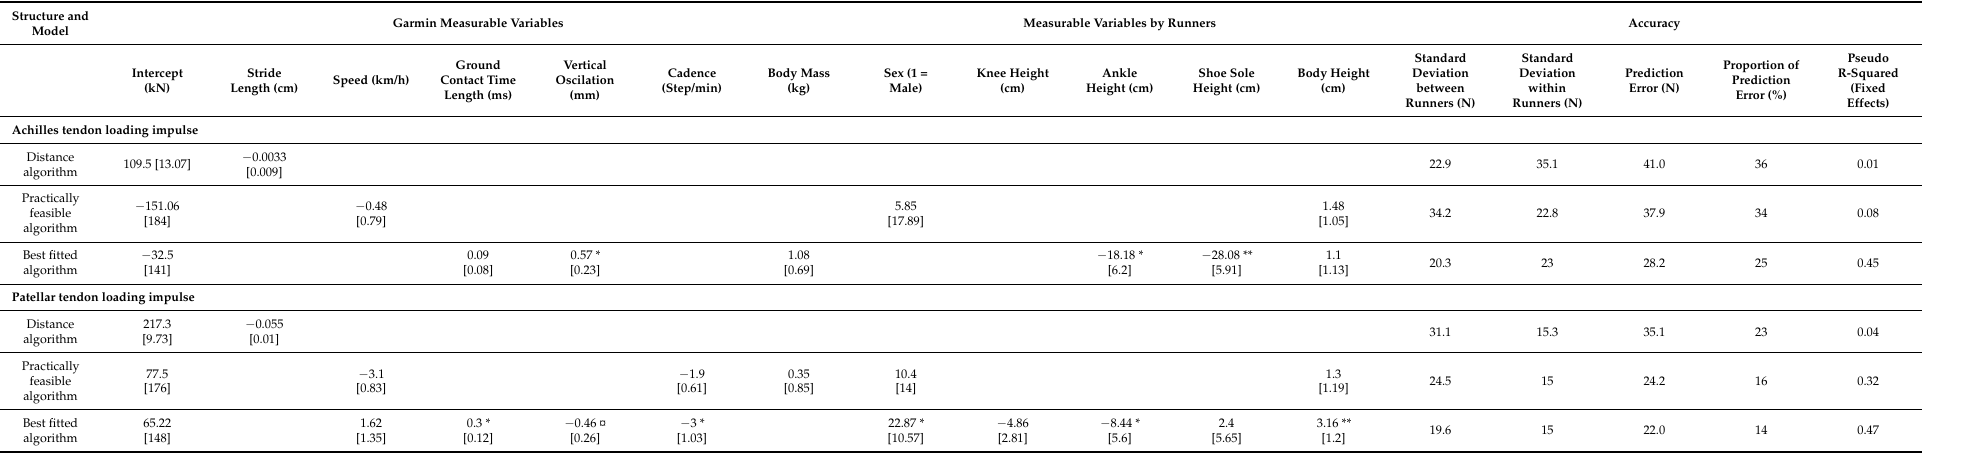
Table 2. The predictive algorithms of the patellar and Achilles tendon impulse load during running based on outdoor measurable